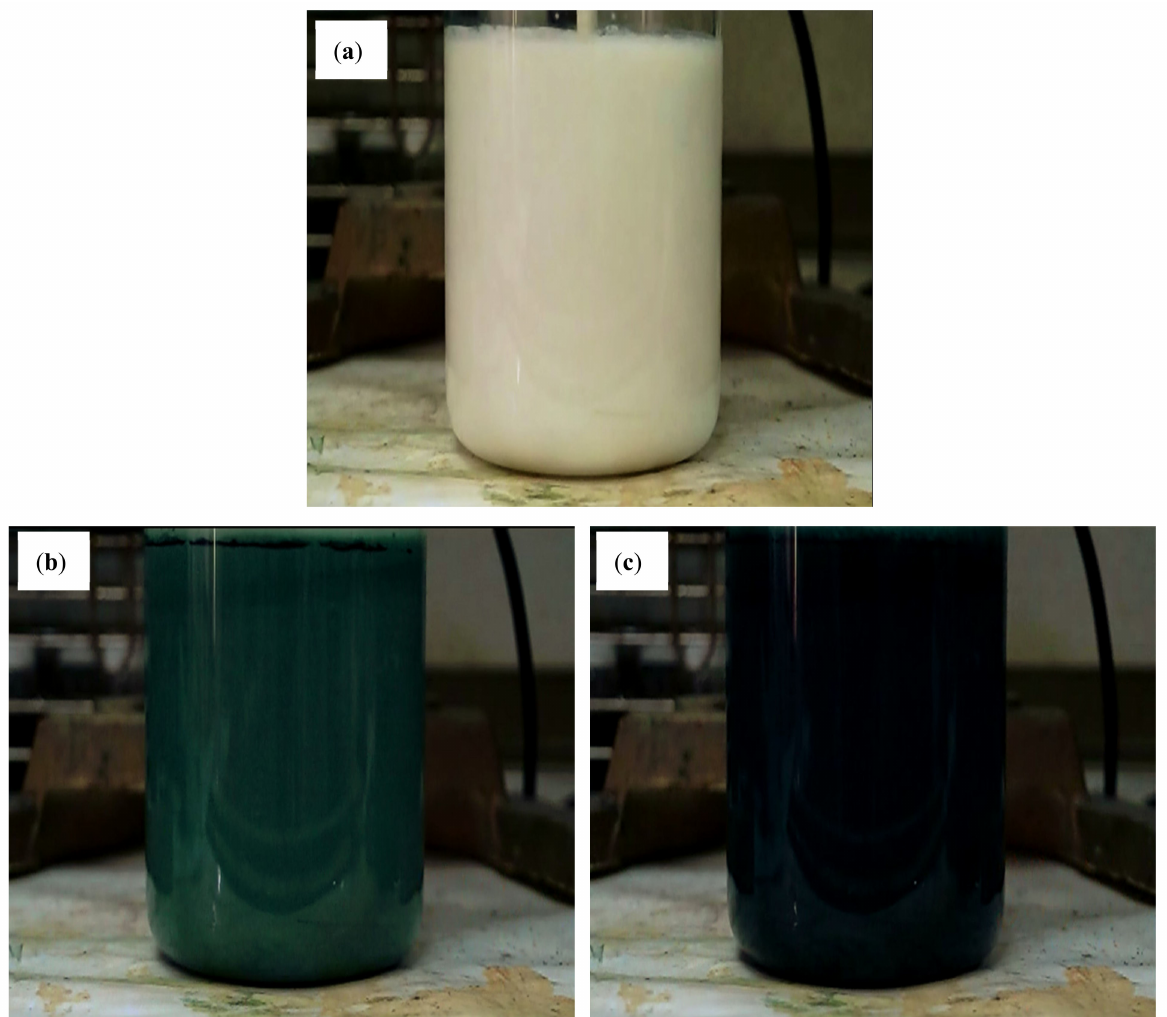
Figure 1. Color changes of the polymerization solution at the weight ratio of AN/ γ -Al 2 O 3 of 3/1 after ( a ) 3, ( b ) 27, and ( c ) 30 min reaction